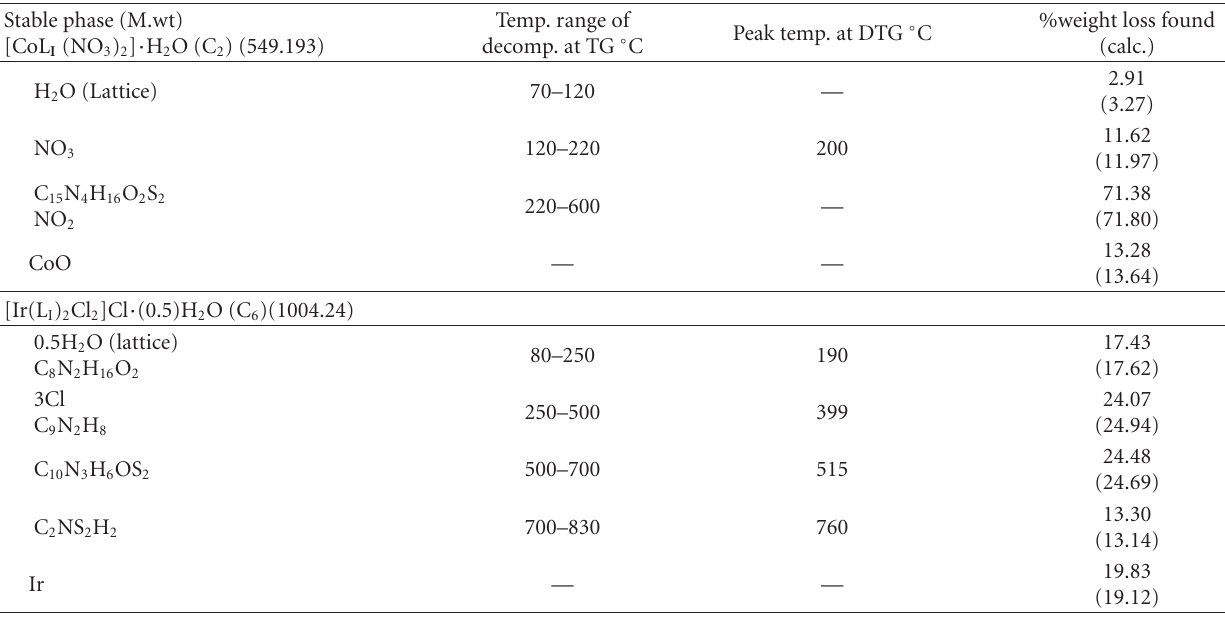
Table 3: Suggested thermal decomposition steps of C 2 and C 6 . Stable phase